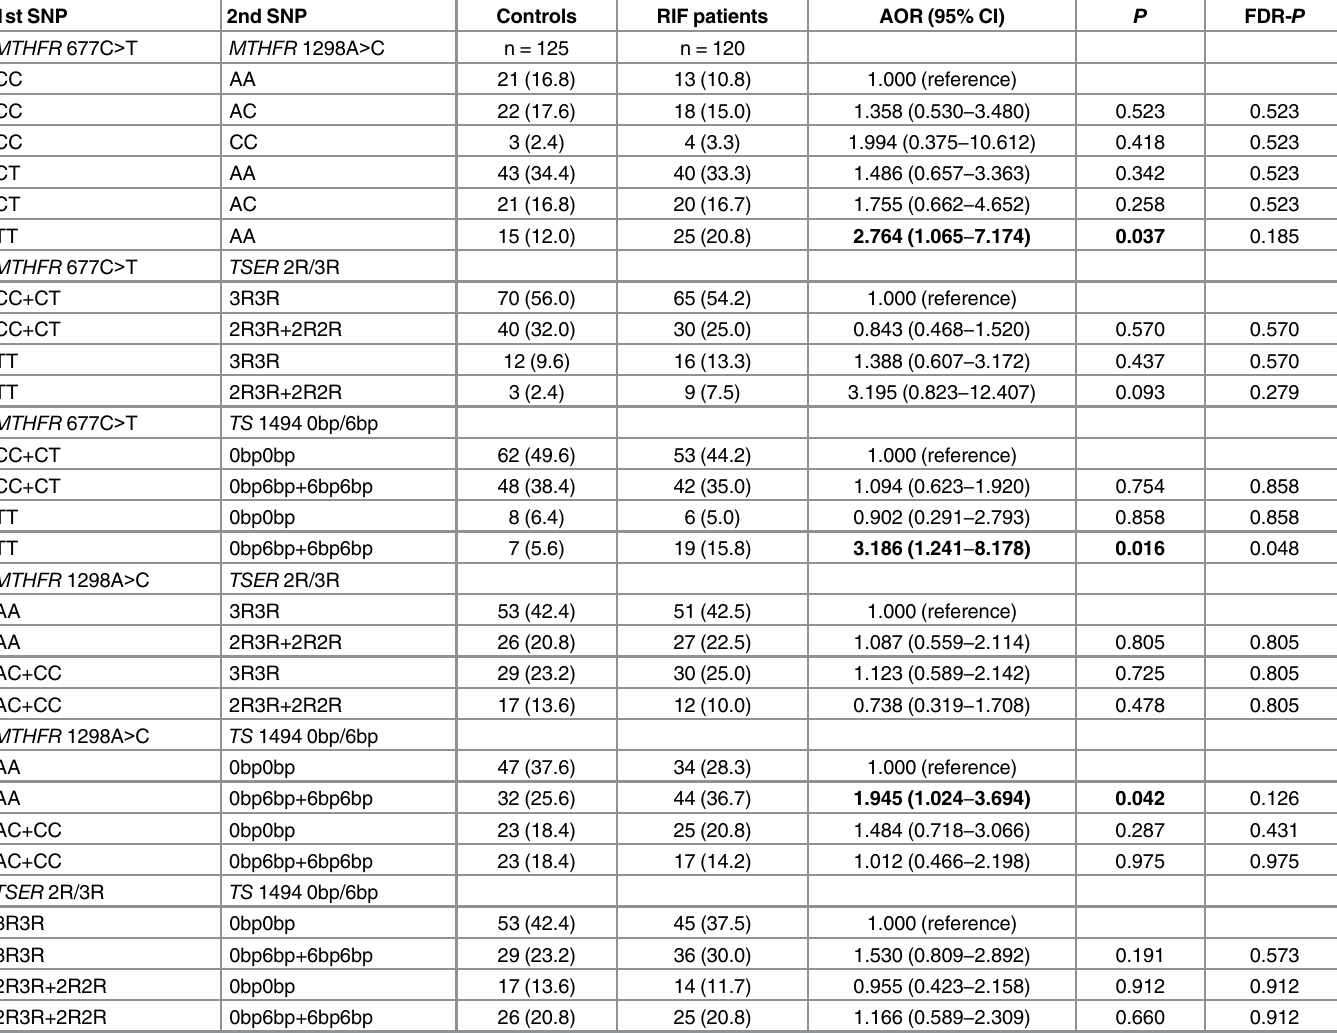
Table 3. The combination model of one-carbon metabolism-related gene polymorphisms between controls and RIF